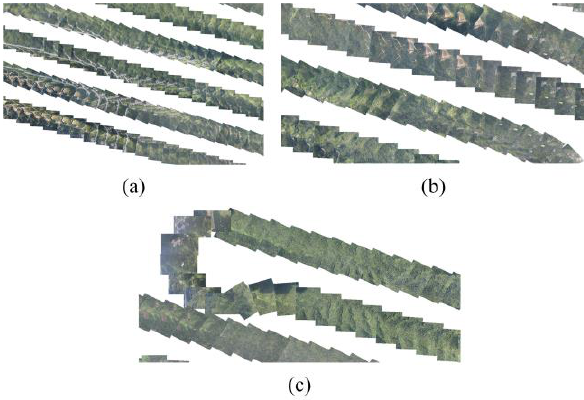
Figure 6. Parts of tracking map with thumbnail photos rotated. (a), (b) and (c) shows the details in track map with images rotated according to yaw angles calculated when initial image network generation in Case II.